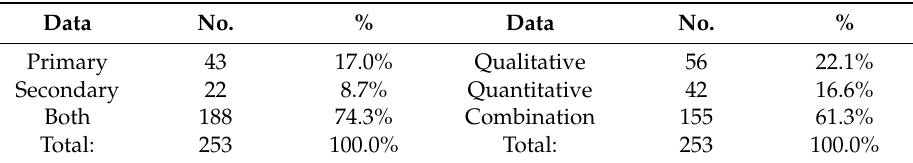
Table 3. Type of data collected in the reviewed papers.